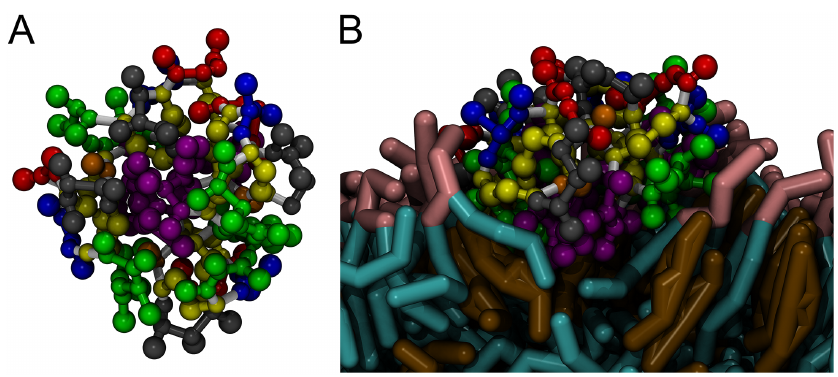
Figure 3. Different conformation of kB1 tetramer. (A) Top view of the tetramer in water. (B) Side view of the tetramer in its membrane-bound state. The structure of kB1 is shown as a CPK model with the same colors as in Figure 1A. Lipid molecules are represented as licorice models. The polar heads and hydrophobic tails of DPPC and DUPC lipids are shown in pink and cyan, respectively. Cholesterol molecules are presented in brown. For clarity of the Figure, water molecules are not